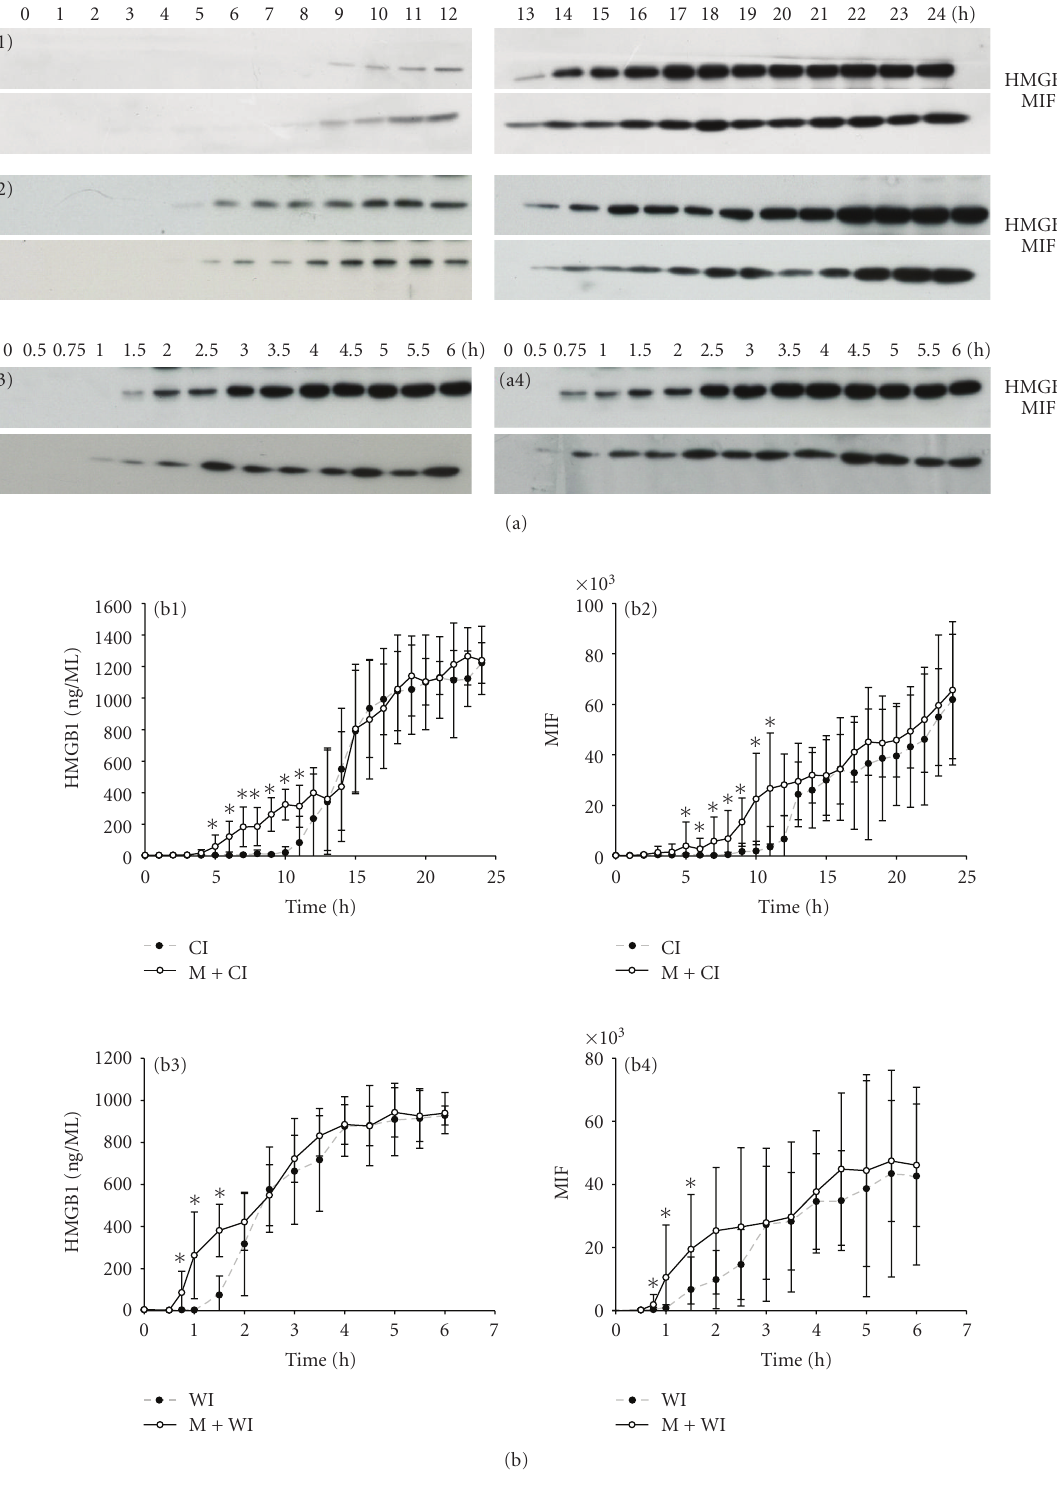
Figure 5: Release of danger signals during ischemic storage of liver. E ffl uent obtained after flushing the liver in half-hourly or hourly intervals for either 24 or 6h was assessed for HMGB1 and MIF using Western blot (a). Release of both danger signals, HMGB1 and MIF, was detected by Western blot. (a1) Cold ischemia; (a2) mechanical stress plus cold ischemia; (a3) warm ischemia; (a4) mechanical stress plus warm ischemia. Band density was assessed using Image J program and expressed as ng/ml (HMBG1) or arbitrary units (MIF) (b). Danger signals were released significantly earlier in both groups subjected to mechanical stress compared with ischemia only group ( P = . 0027; P = . 002, resp.). At earlier time points (0.75–1.5 h/5–11 h in warm/cold ischemic ischemia), the relative concentration of HMGB1 and MIF in the e ffl uent was also significantly higher compared with groups subjected to ischemia only ( ∗ P < .